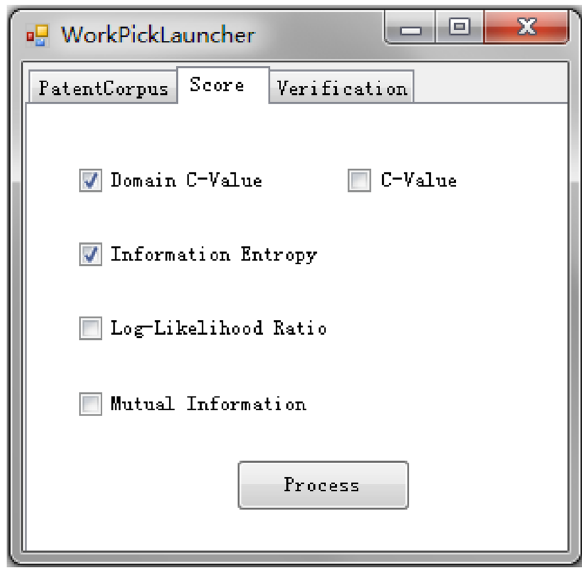
Figure 3. Extraction algorithm selection interface.